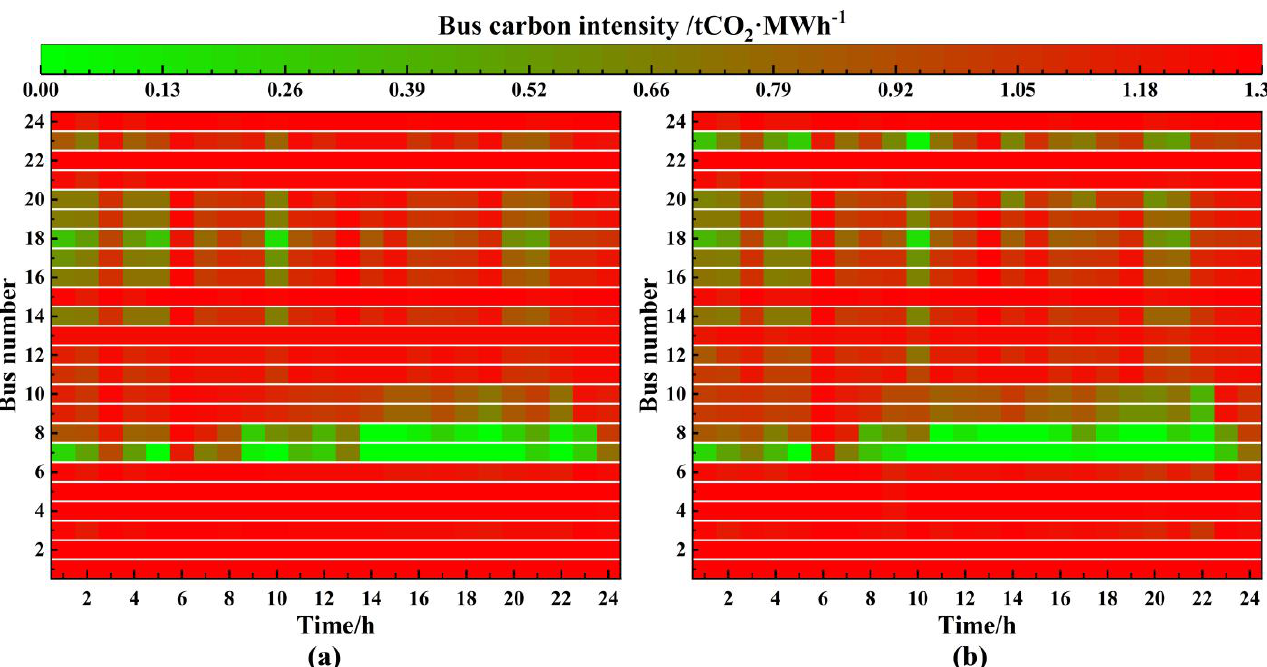
Figure 8. Planning results of different cases in Scenario 1.